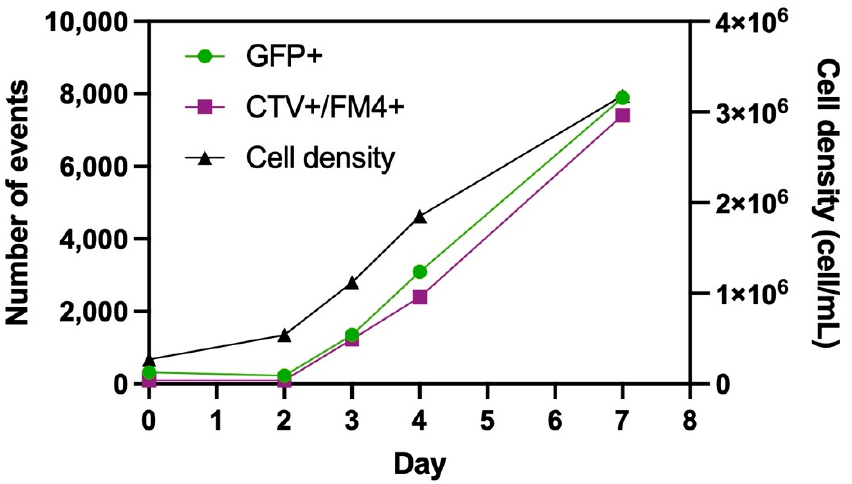
Figure 1. Analysis of Clone 92 supernatant by flow virometry: Quantification of GFP+ events and CTV+/FM4+ events over cell culture days as measured on the BD Fortessa flow cytometer.